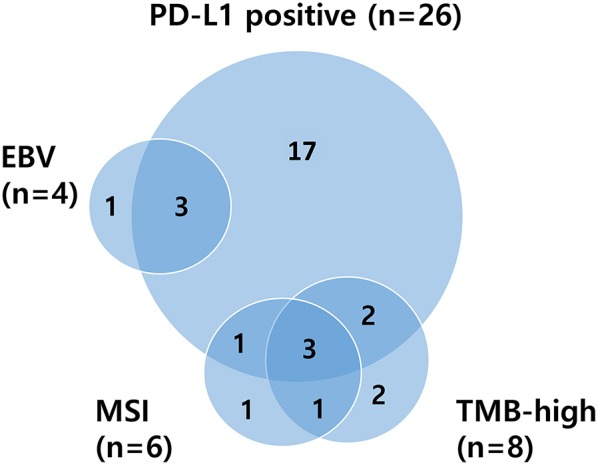
Venn diagram illustrating relationships between PD-L1 positivity, MSI status, EBV positivity, and TMB. PD-L1, programmed death-ligand 1; MSI, microsatellite instability; EBV, Epstein–Barr virus; TMB, tumor mutational burden.